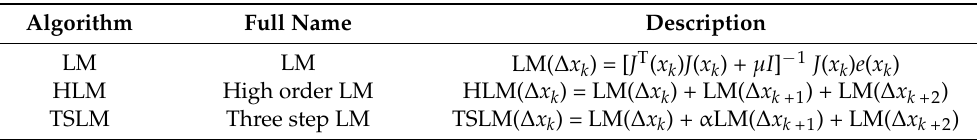
Table 1. Description table of other LM family algorithms participating in the comparative test.